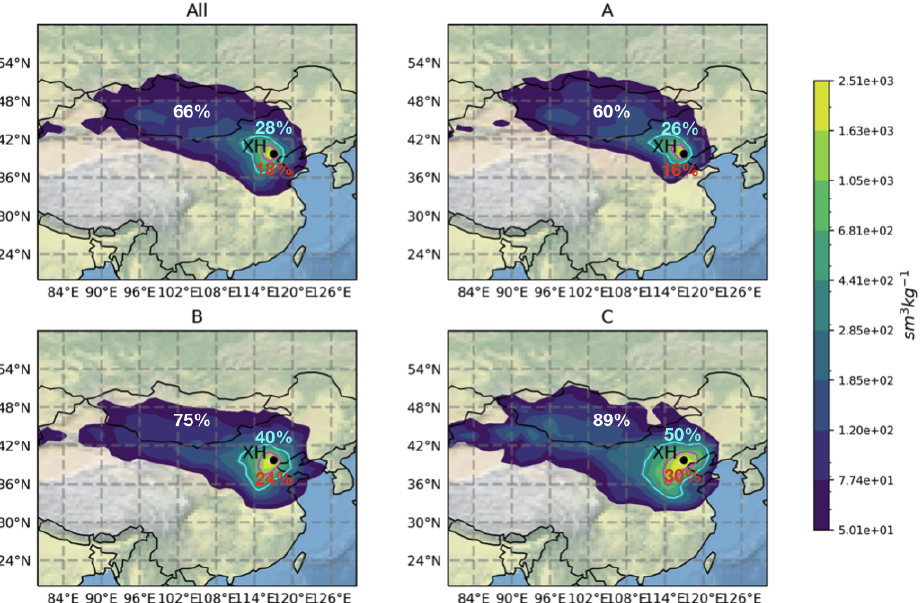
Figure 9. Spatial distributions of the air mass response sensitivity in 10d backward simulations at Xianghe using the FLEXPART v10.4 model for all FTIR measurement days (All) and categories A, B, and C. Sensitivity is given in units of sm 3 kg − 1 . The Xianghe site is marked with a black dot. The values indicate the percentages of the emission response sensitivity larger than 50 (deep blue edge), 300 (cyan circle), and 1000sm 3 kg − 1 (red circle)